Question: State the chart type depicted above.
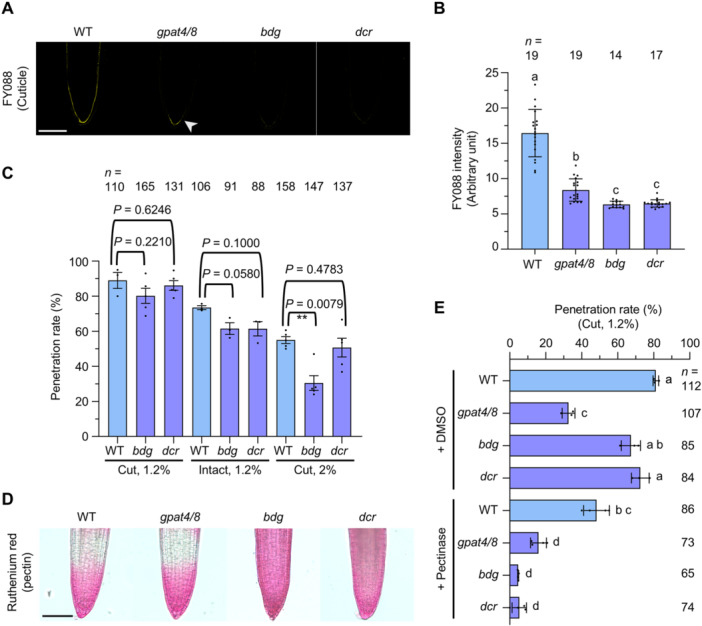
Answer: bar